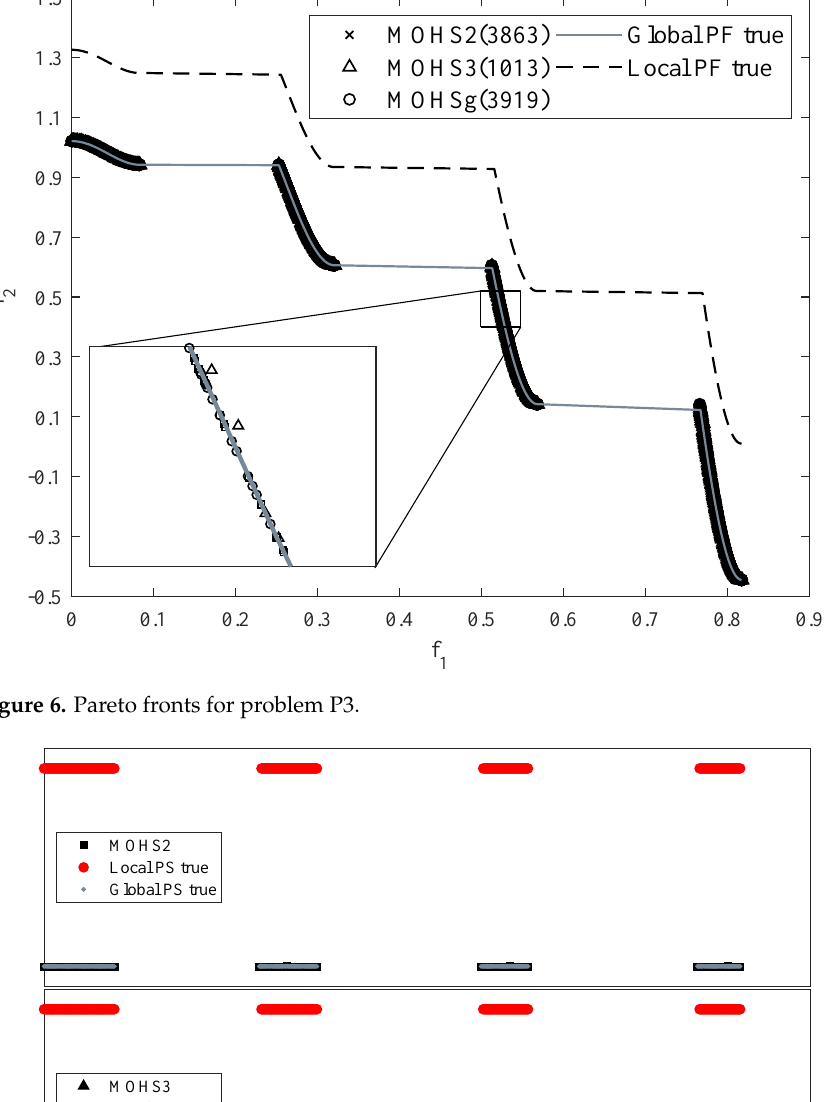
Figure 6. Pareto fronts for problem P3.